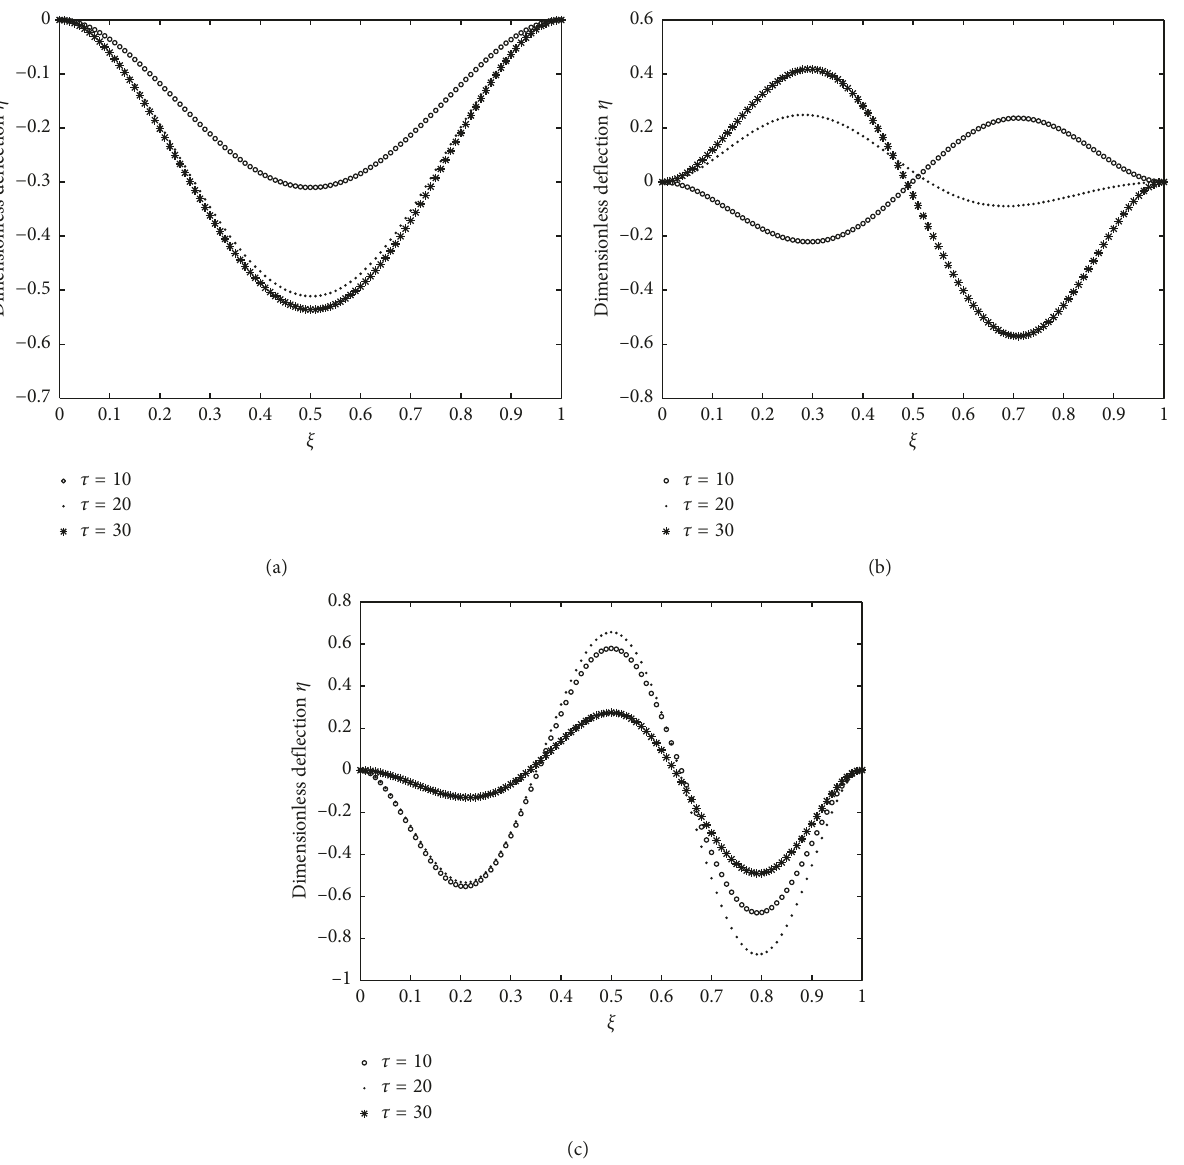
Figure 18: The resonance responses of the clamped-clamped pipe with u � 2 under different supports movement frequencies: (a) ω � 20.79; (b) ω � 60.10; (c) ω �